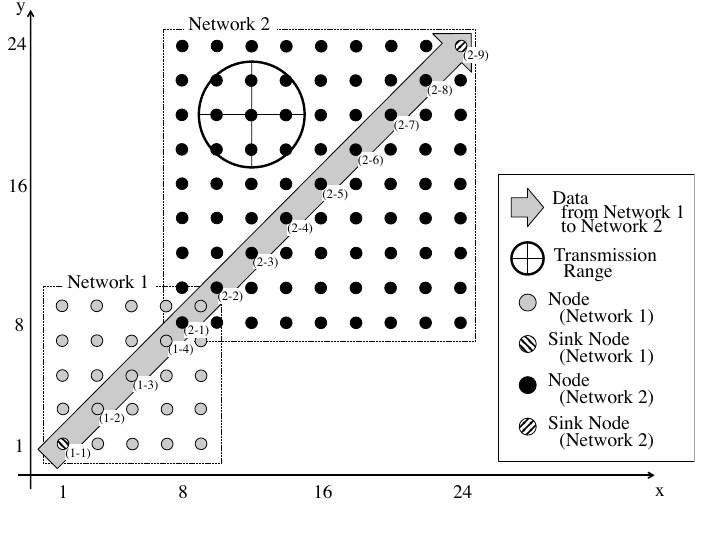
Table 1. Parameter settings.